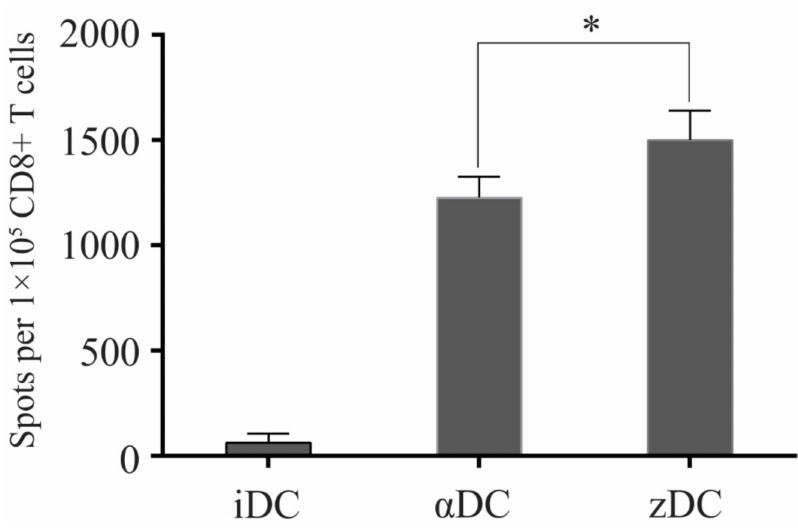
Figure 6. zDCs have a superior capacity to induce melanoma-specific CD8+ T cell responses. We sensitized autologous CD8+ T cells using two rounds of stimulation with iDCs, α DCs, or zDCs. The DCs were pulsed in advance with melanoma-associated peptides gp100 (154–162), gp100 (209–217), tyrosinase (369–377), and melan-A (26–35). After 14 days in DC:T cell co-culture, the T cells were har- vested and re-stimulated with T2 cells as stimulators (previously pulsed with peptides) on pre-coated, IFN- γ ELISPOT strips for 24 h. The number of spot-forming colonies was determined and analyzed using an ELISPOT reader. The data are shown as mean ± SD of duplicates of three independent experiments, involving CD8+ T cells and DCs from different donors. Statistical significance between individual pairs was calculated using Student’s unpaired t test (* p <